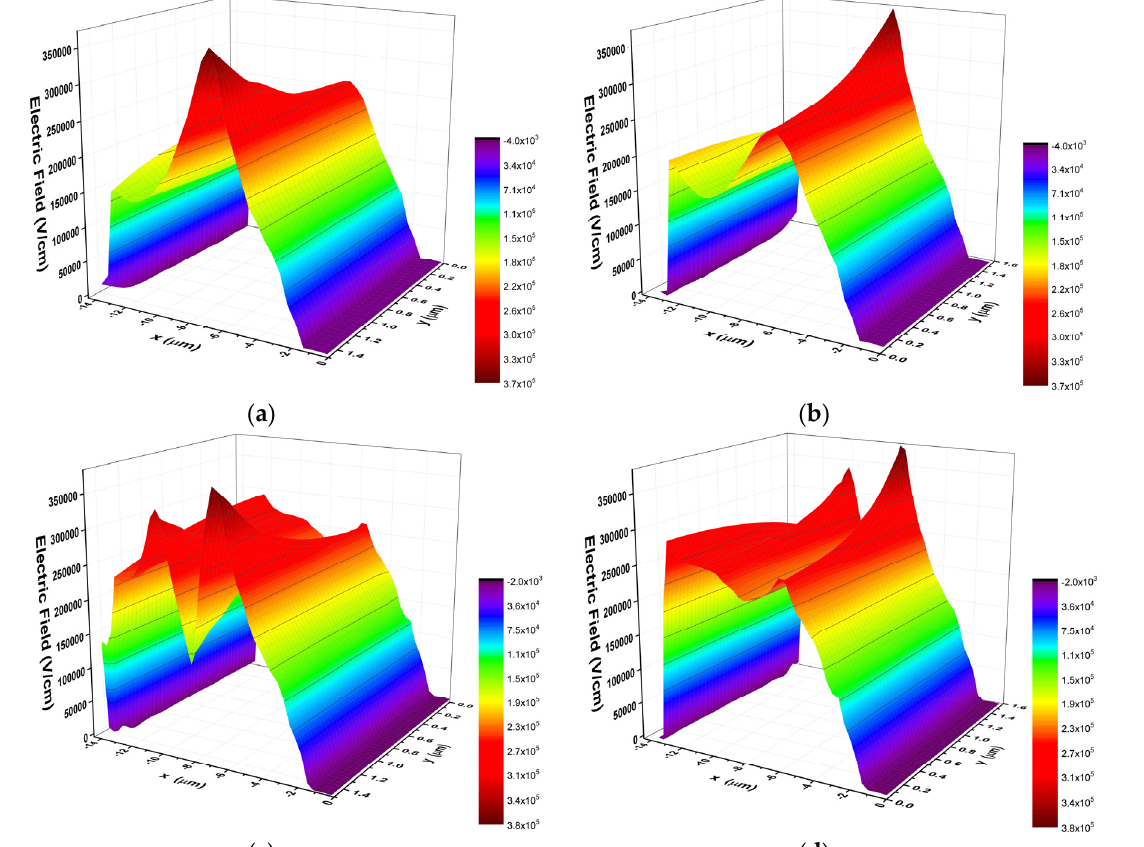
Figure 4. Three-dimension electric field distributions of the ( a ) front view and ( b ) back view of the SGRSO UMOSFET and the ( c ) front view and ( d ) back view of the DFSGRSO UMOSFET with the same n-drift area doping concentration.